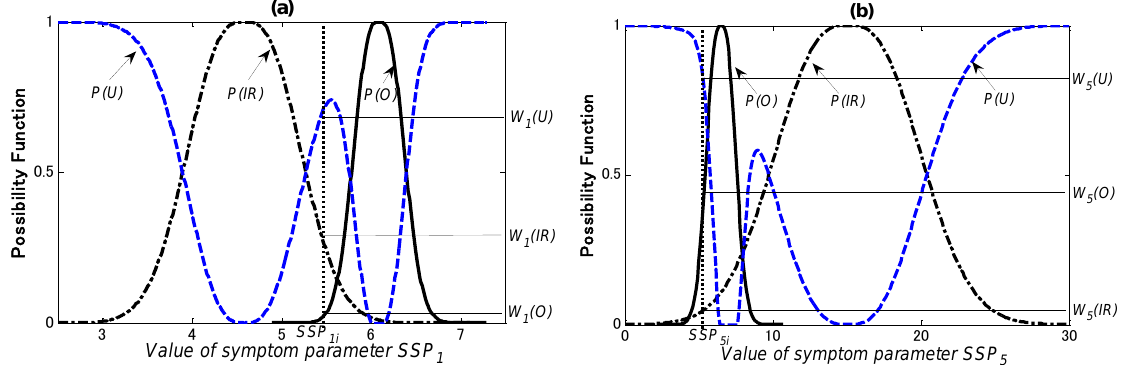
and ( b ) SSP for second diagnostic step. 1 5